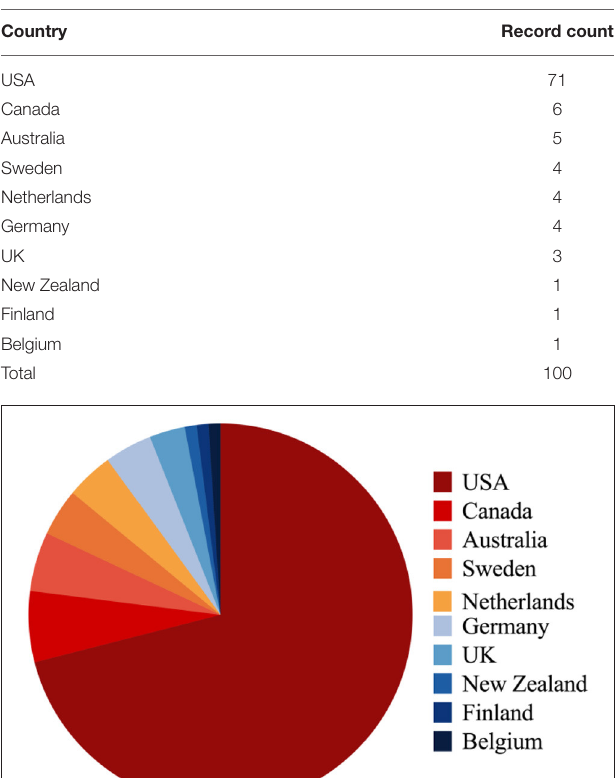
FIGURE 2 | Country distribution of the top-cited articles.